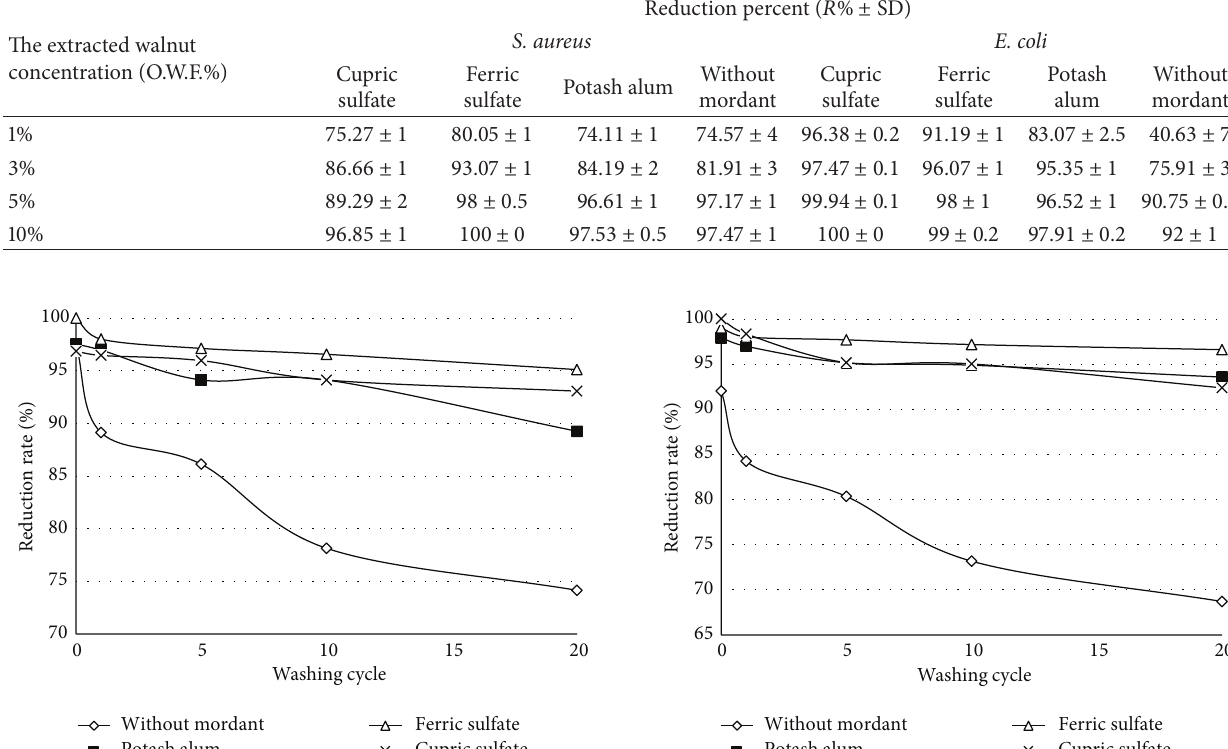
Table 2: Reduction percentage of E. coli and S. aureus in different conditions (each experiment was repeated five times).